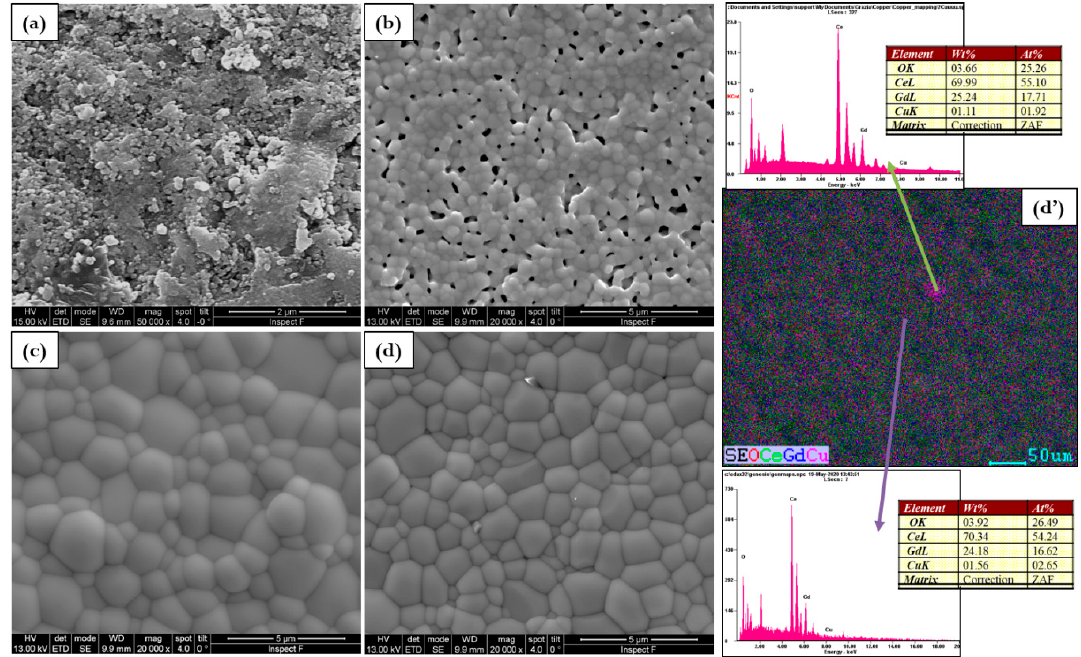
Figure 4. Microstructure evolution for ( a ) GDC, ( b ) 0.5 Cu, ( c ) 1 Cu, ( d ) 2 Cu, and ( d’ ) EDS mapping of 2 Cu sintered at 1000 °C.